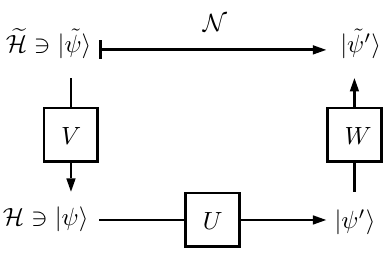
Figure 4 . Traversable wormhole as a map between code